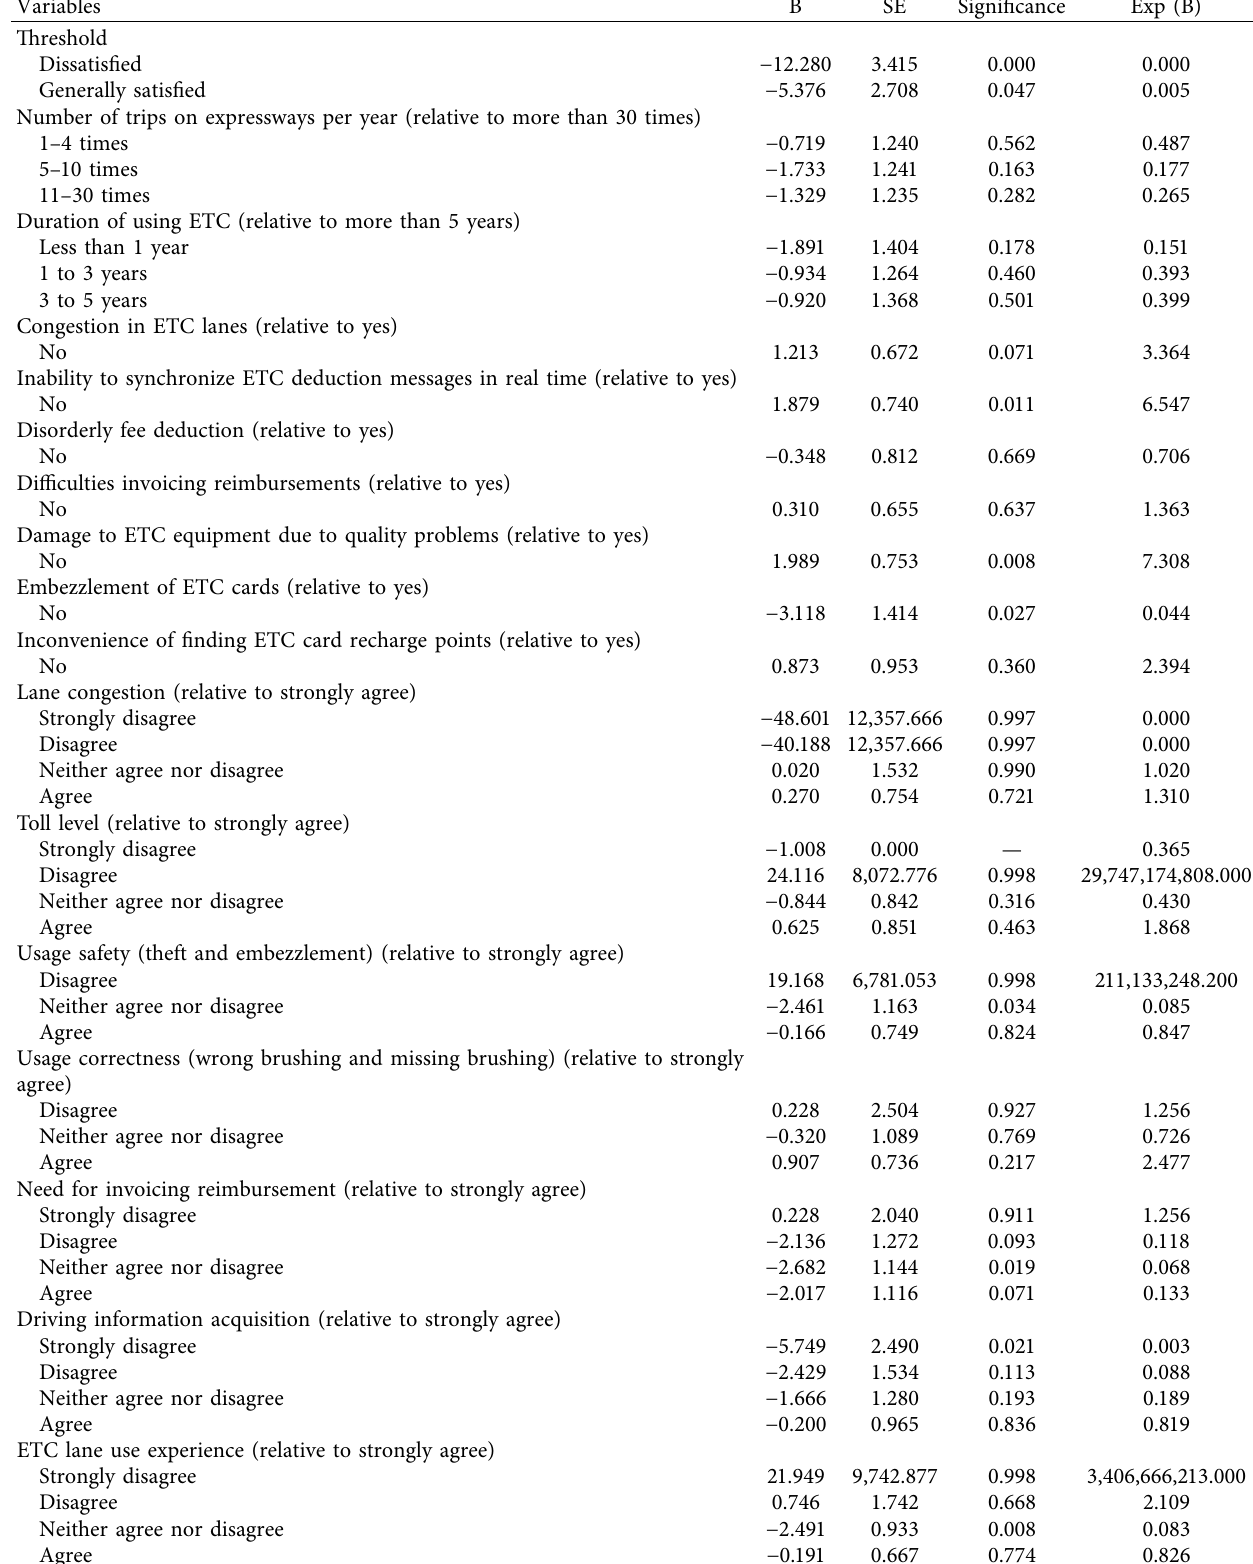
Table 4: Ordinal logistic regression analysis results of the samples of